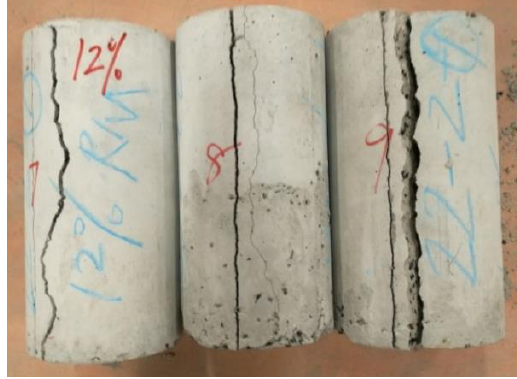
Table 8. Test results of indirect tensile strength.